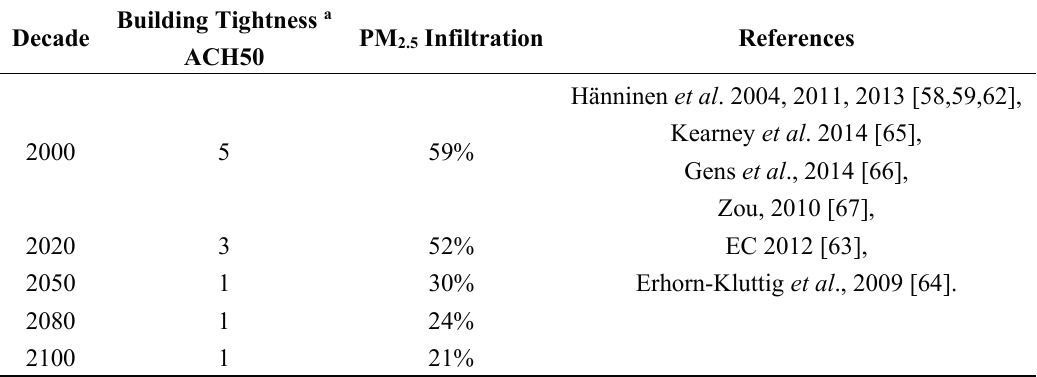
Table 2. Projected PM 2.5 infiltration and air tightness of buildings in Nordic